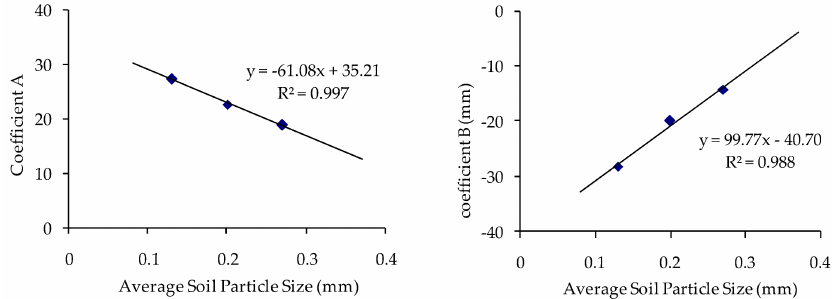
Figure 5. Relationship between the regression coefficient and the average soil particle